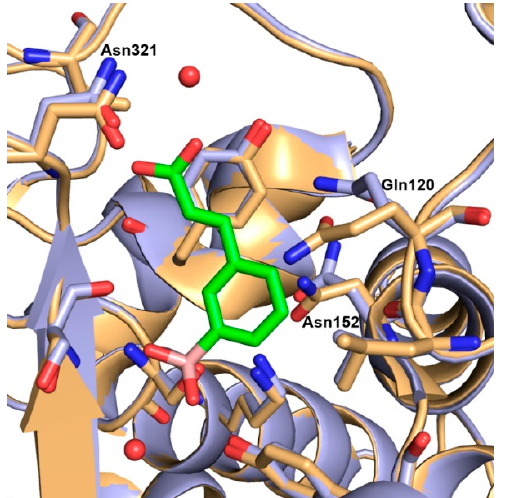
Figure 6. Overlay of the native Pa AmpC active site (light orange, PDB ID: 4GZB [ 30 ] ) on Pa AmpC (light blue) covalently bound to 3 (green). The residues surrounding the ligand are shown as sticks. Sidechains of the residues showing the major structural change are labeled. Water molecules from the Pa AmpC: 3 structure are shown as red spheres.